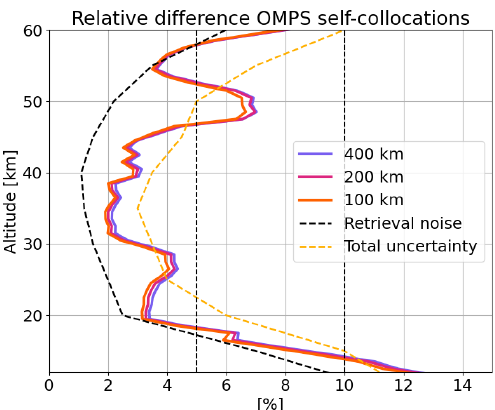
Figure 14. Relative difference between self-collocated OMPS-LP observations when changing the collocation criteria. Superimposed, typical retrieval noise and total random uncertainty for high lati-